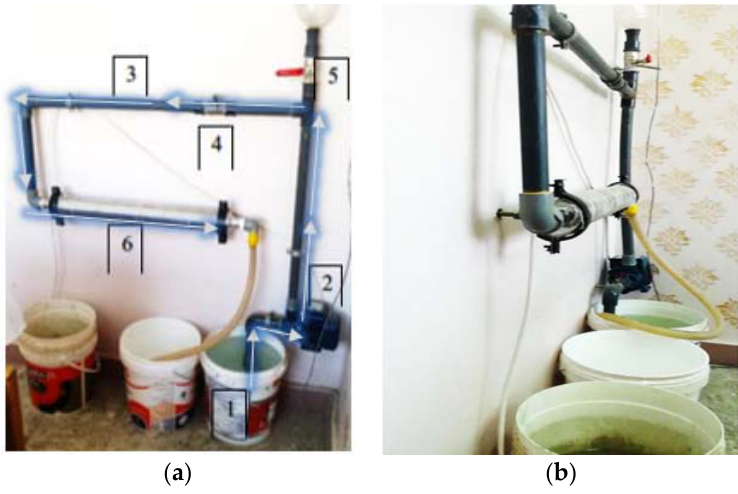
Figure 4. Water magnetization process. ( a ) Magnetization device composition; ( b ) Water circulation.